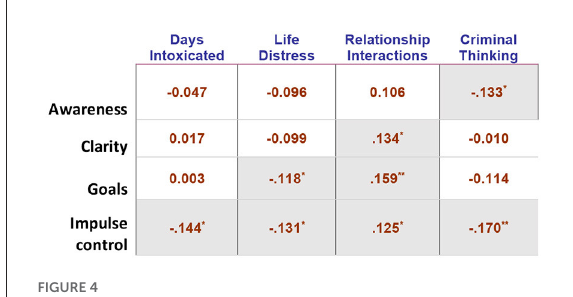
FIGURE4 Correlation table of change in emotion regulation and outcome indicators. Table shows Pearson ‘ r ’ correlation between change (pre-to-post) score on 4 of the 6 DERS subscales and several outcome indicators at final assessment. Gray cells are significant, * < 0.05, ** < 0.01. For directionality of associations, note that: higher score on RI = healthier relationship interactions; higher score on LDI = more distress; higher score on DERS = less emotion regulation; higher score on CTS = more criminal thinking; higher DERS change = improved emotion